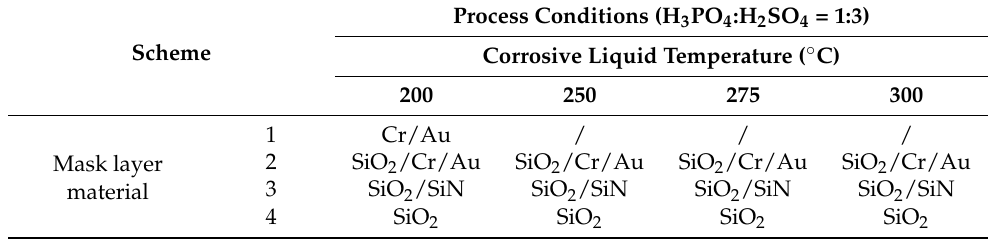
Figure 3. Sapphire surface states etched by different volume ratios of etching solution. ( a ) H 3 PO 4 :H 2 SO 4 = 1:1; ( b ) H 3 PO 4 :H 2 SO 4 = 1:2; ( c ) H 3 PO 4 :H 2 SO 4 = 1:3. Table 1. Process experiment parameters.